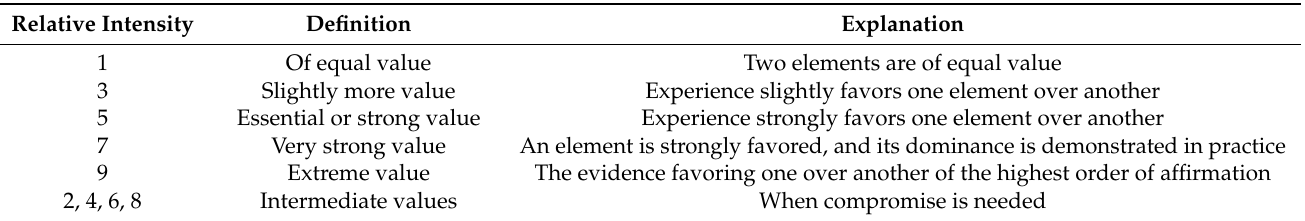
Table 5. The fundamental scale of AHP [26].